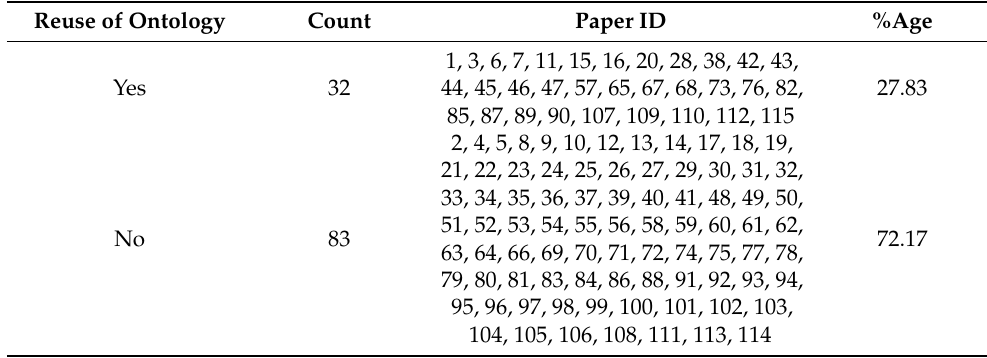
Table 5. Reuse of Ontologies in Different Publications. Reuse of Ontology